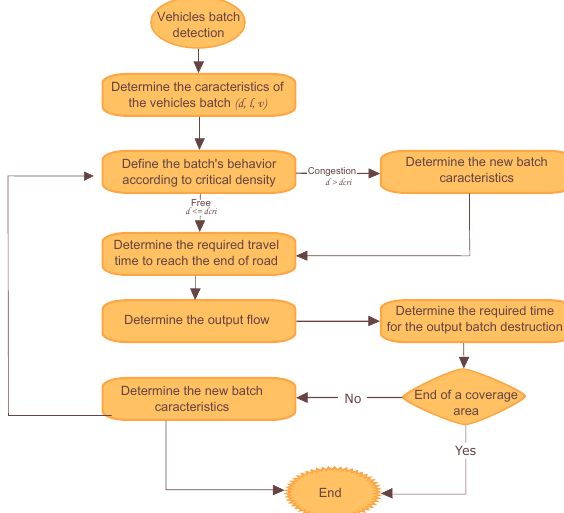
Figure 3. The procedure of the model